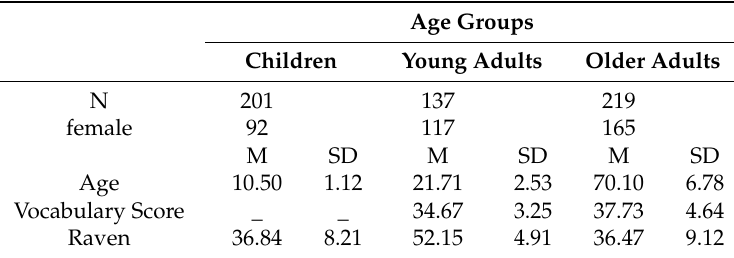
Table 1. Participants’ Characteristics by Age